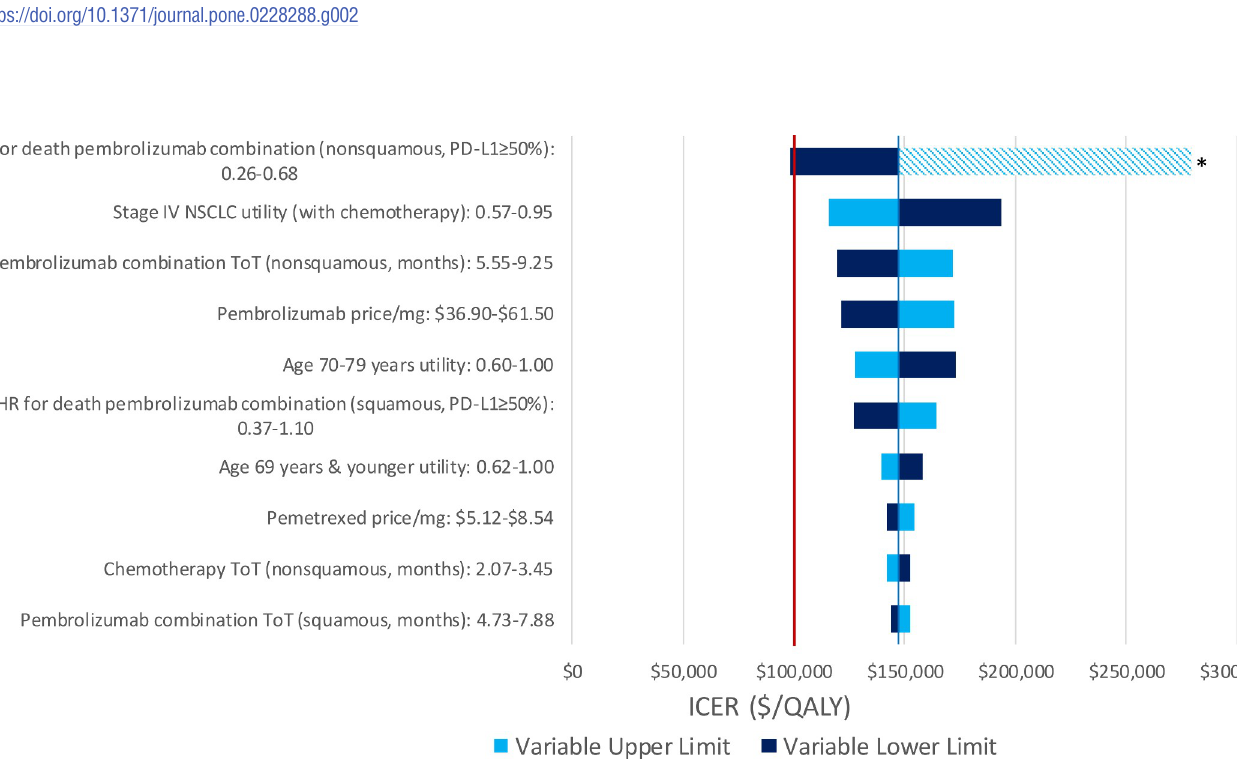
PLOS ONE | https://doi.org/10.1371/journal.pone.0228288 January 29,